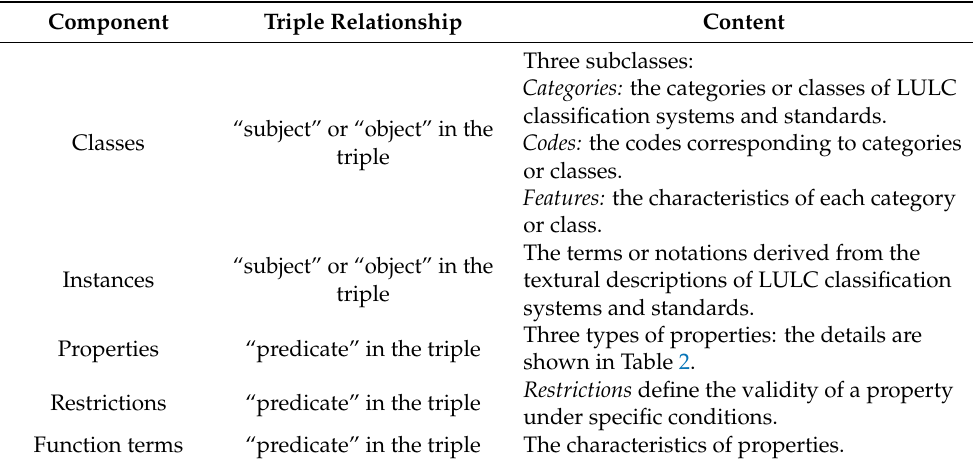
Figure 1. Conceptual model of LuLcSys-Ontology. The details of LuLcSys-Ontology are shown in Table 1. Table 1. Details on components of